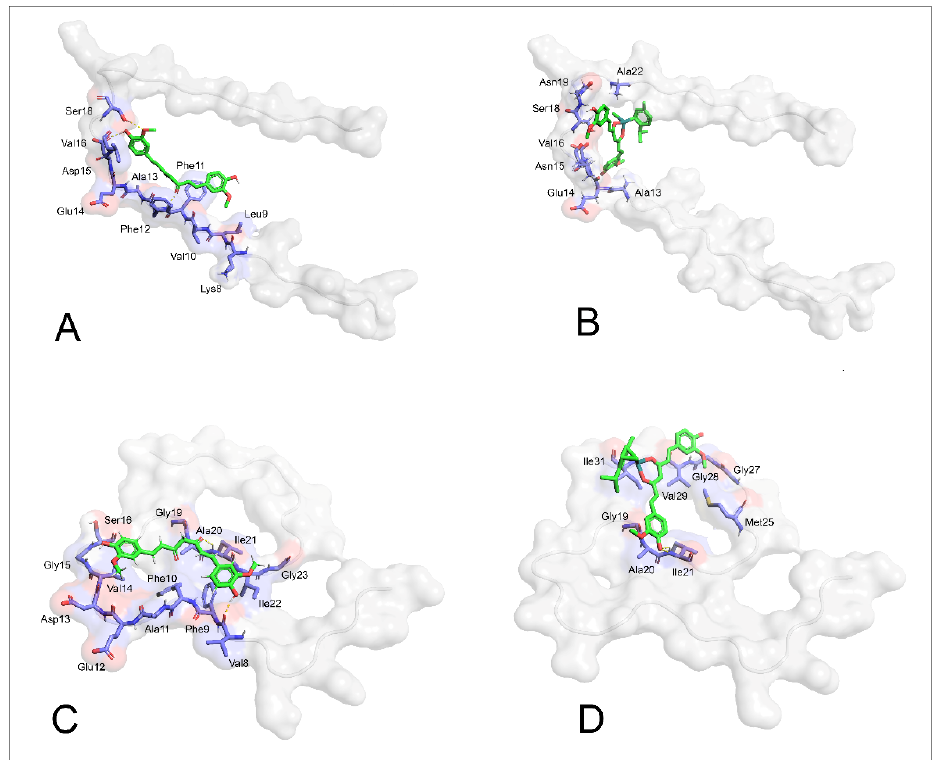
Figure 1. Characterization of the binding interface of the protein − ligand complexes based on molecular docking. Comparative visualization of binding models of curcumin and RuCurcumin with A β (1–40) (insets ( A , B )) and A β (1–42) monomers (insets ( C , D )). Amyloid- β peptides are displayed as transparent grey surfaces, and residues constituting the binding regions are rendered as light blue sticks.